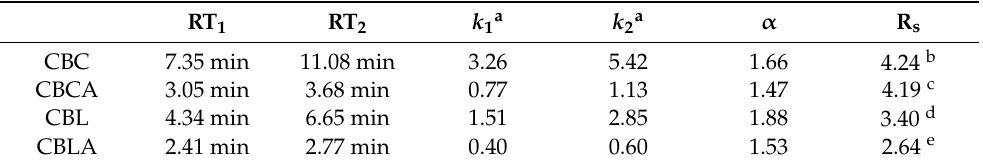
Table 2. Chromatographic performance of analytical cannabinoid separations on IK with Hex-DCM (-TFA) = 80-20 (-0.1) mobile phases.